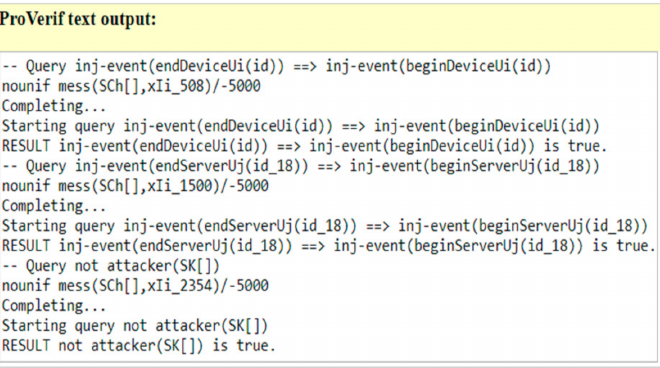
Figure 10. Output of query